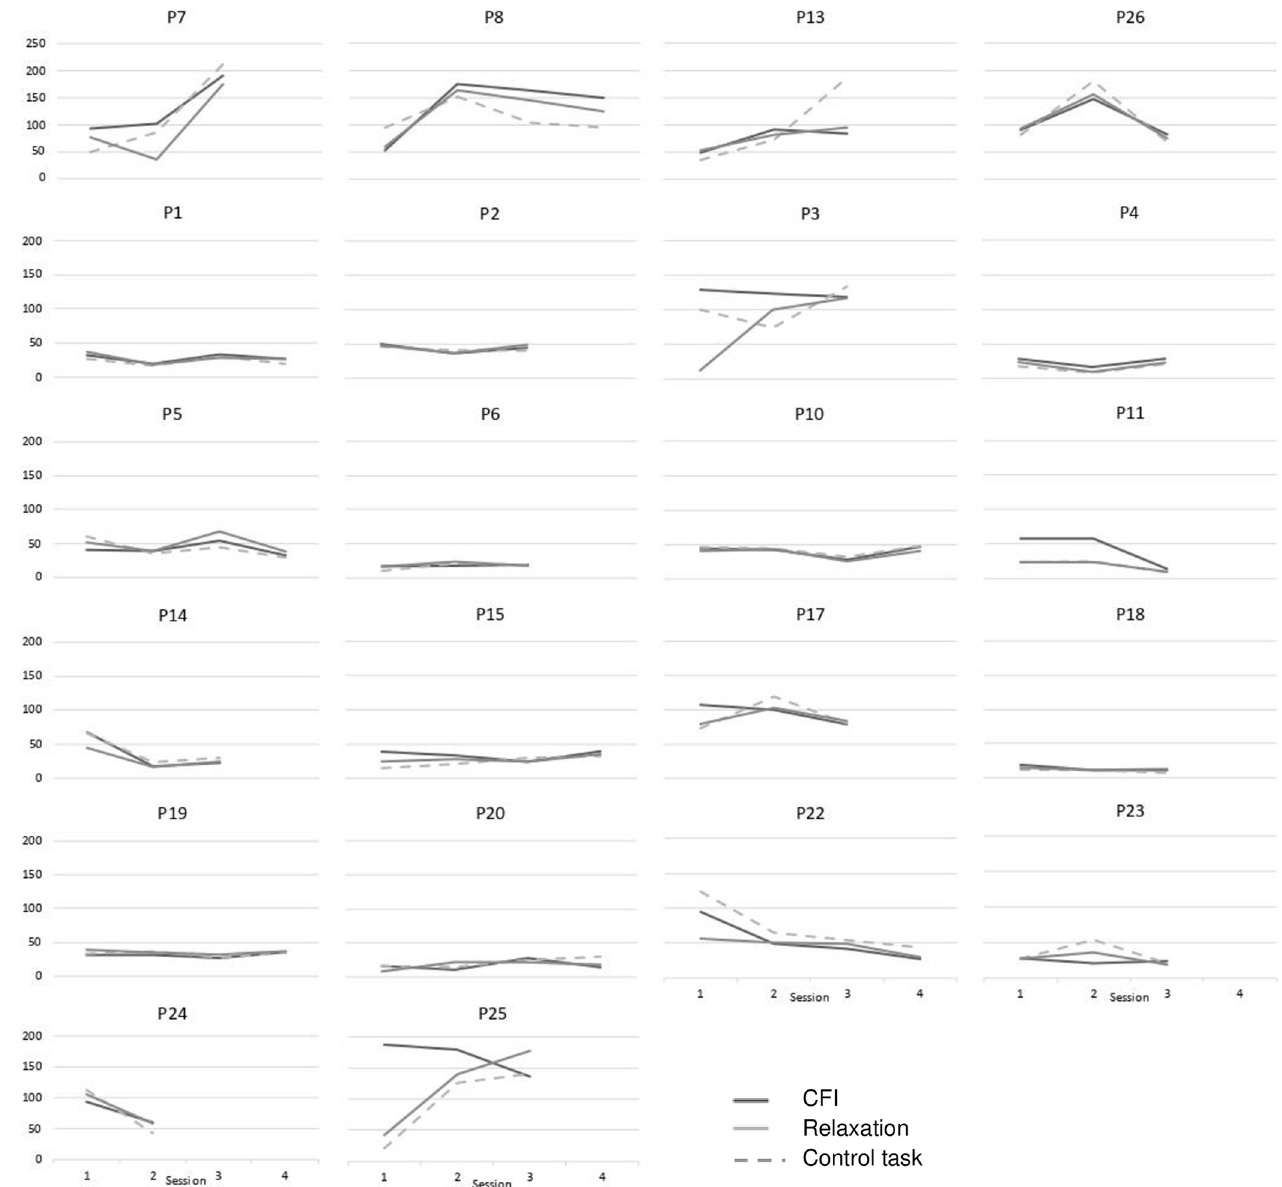
Fig 3. RMSSD HRV responses to CFI and control task over time, for participants who attended multiple sessions (N = 22). Note: X-axis represents sessions over time; Y-axis represents RMSSD